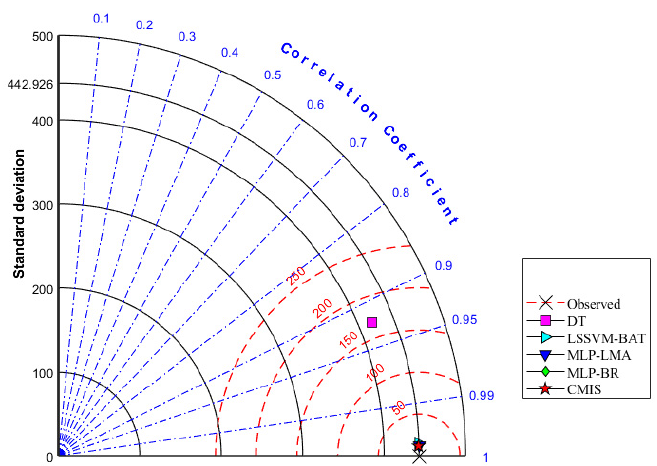
Figure 9. Taylor diagram for the offered methods based on Model (II).